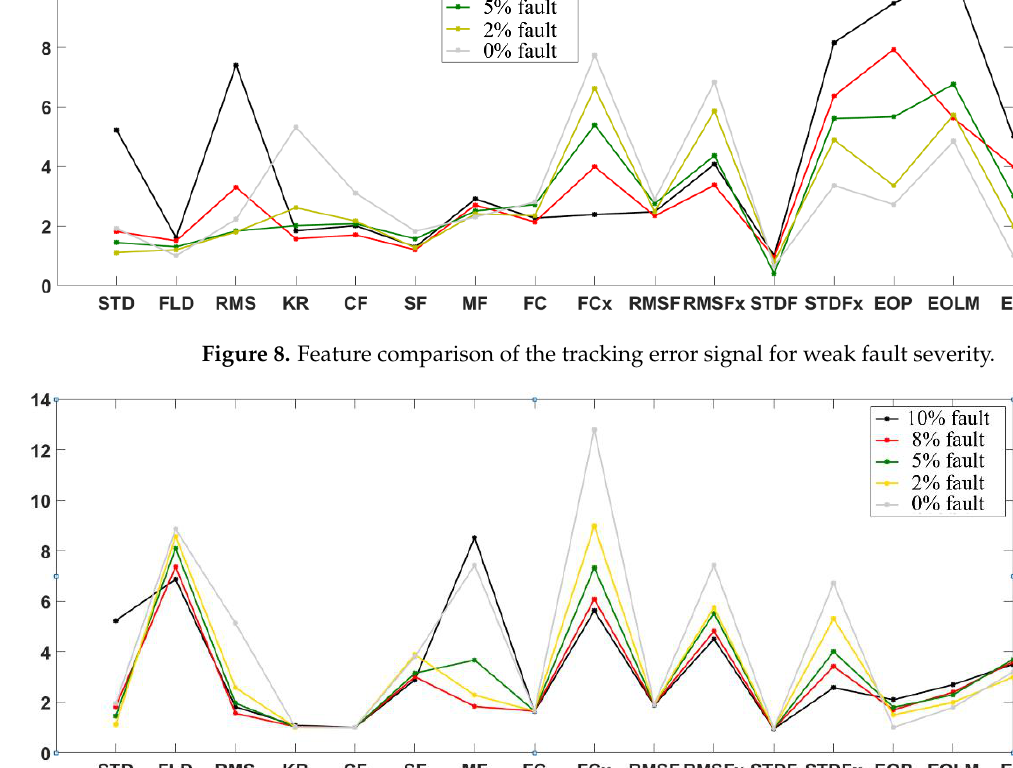
Table 6. Useful features of the surge velocity signal.